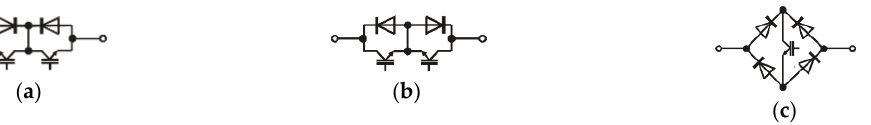
Figure 2. Main topologies for bi-directional switches: ( a ) common emitter IGBT, ( b ) common collector IGBT, ( c ) diode bridge and IGBT.